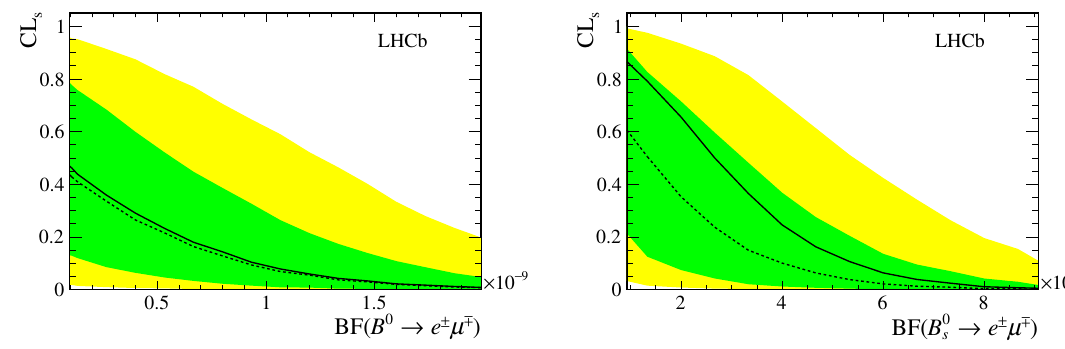
Figure 5 . Results of the CL s scan used to obtain the limit on (left) B ( B 0 ! e (cid:6) (cid:22) (cid:7) ) and (right) B ( B 0 ! e (cid:6) (cid:22) (cid:7) ). The background-only expectation is shown by the dashed line and the 1 (cid:27) and 2 (cid:27) s bands are shown as dark (green) and light (yellow) bands respectively. The observed limit is shown as the solid black